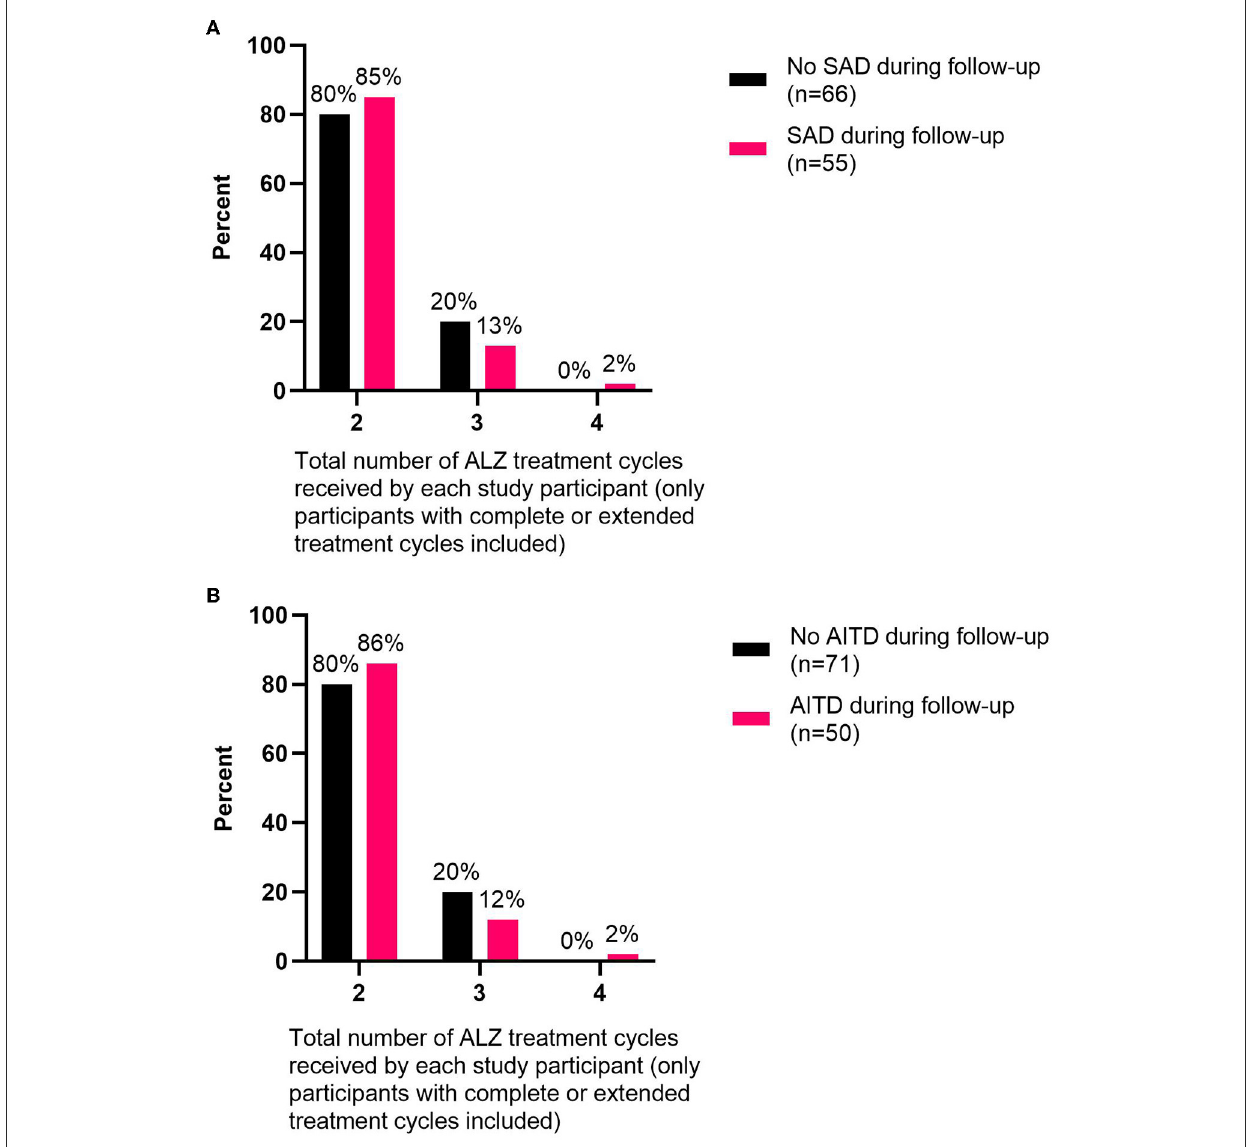
FIGURE3 Total number of ALZ treatment cycles delivered relative to the percent of participants with/without autoimmune disorders during follow-up. The numbers of ALZ treatment cycles are shown for (A) study participants (only participants with complete or extended treatment cycles included) that developed SADs ( n = 55) or did not develop SADs ( n = 66) during follow-up and (B) study participants (only participants with complete or extended treatment cycles included) that developed AITDs ( n = 50) or did not develop AITDs ( n = 71) during follow-up. ALZ, alemtuzumab; SAD, secondary autoimmune disorder; AITD, autoimmune thyroid